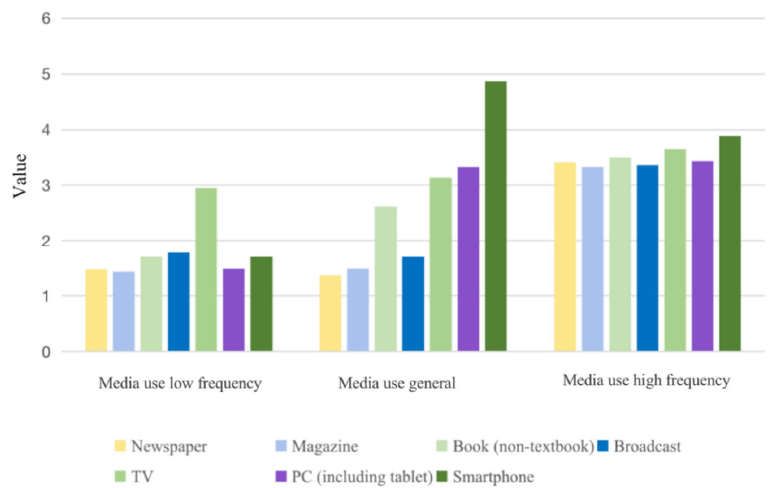
Figure 1. Profile of potential categories of media use.